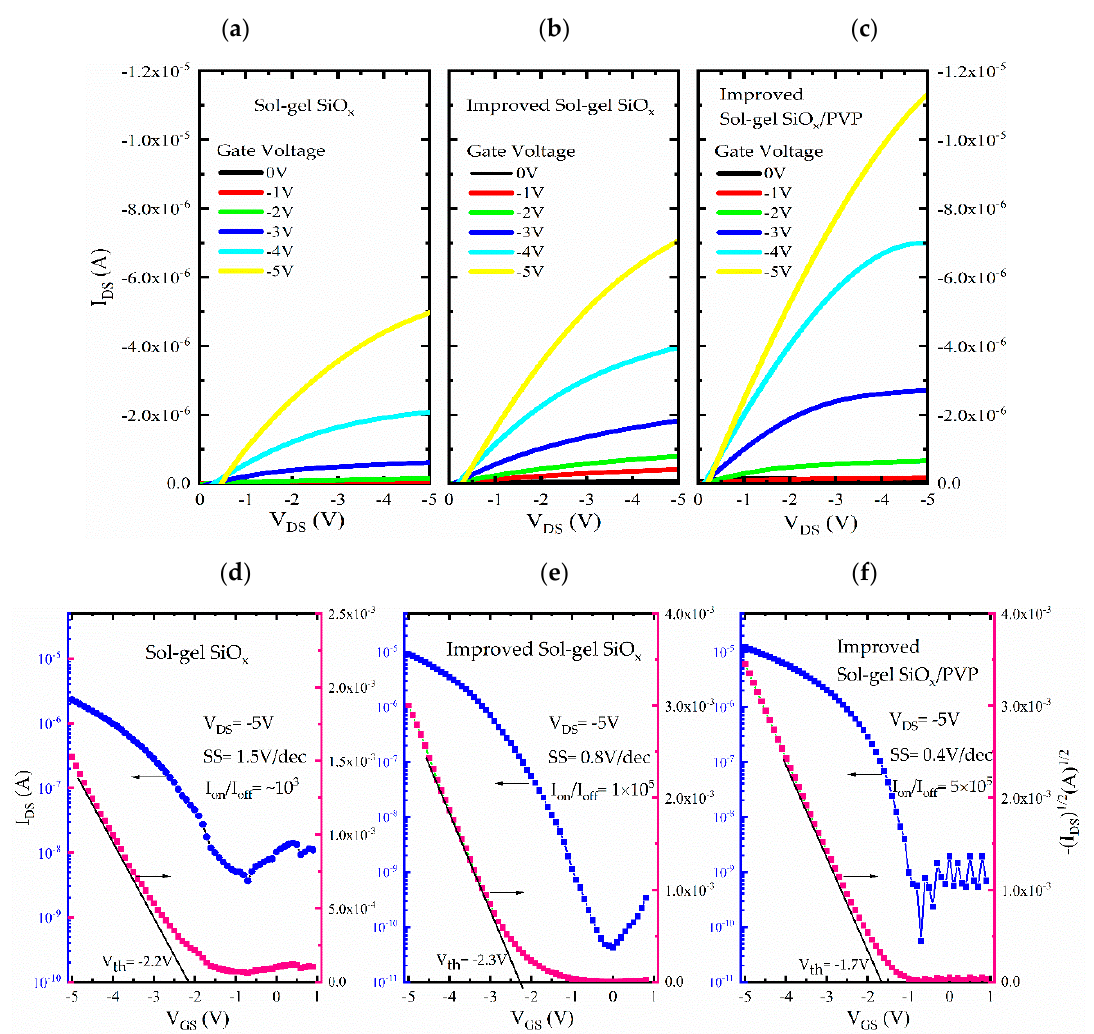
Figure 4. The output and transfer curves of the OTFTs with ( a , d ) sol–gel SiO x , ( b , e ) improved sol–gel SiO x , ( c , f ) improved sol–gel SiO x / PVP dielectric. ( a ), ( b ), ( c ) are in the same scale. The subthreshold slope ( SS ) can be extracted by Equation (1) [3]: